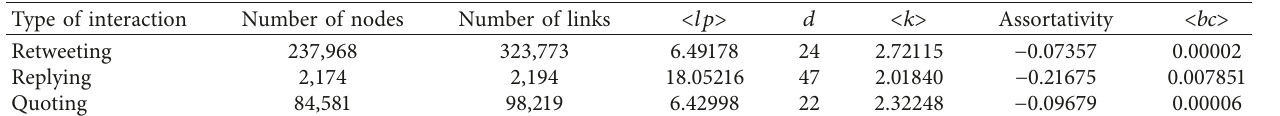
Figure 1: From March 11 until May 26 in 2021 replying (a), retweeting (b), and quoting (c) interactions networks. Table 2: Main structural properties of the GC of the interaction